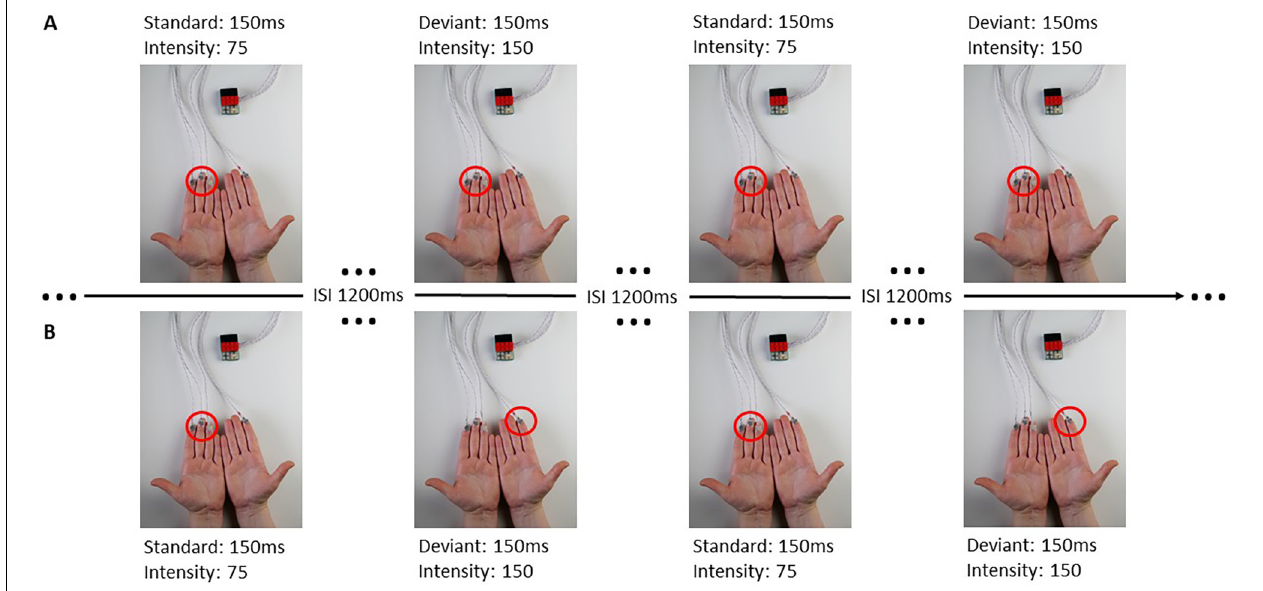
FIGURE 1 | BRIX 2 with extension module and experimental procedure. Panel (A) represents a block with all stimuli presented ipsilaterally at the left fingers, the red circle indicating the activated stimulation site. Panel (B) demonstrates a contralateral block with standard stimuli presented at the left fingers and deviant stimuli presented at the right index. The sequence of standard and deviant stimuli in this Figure is an example. Each block consisted of 200 standard and 40 deviant stimuli.